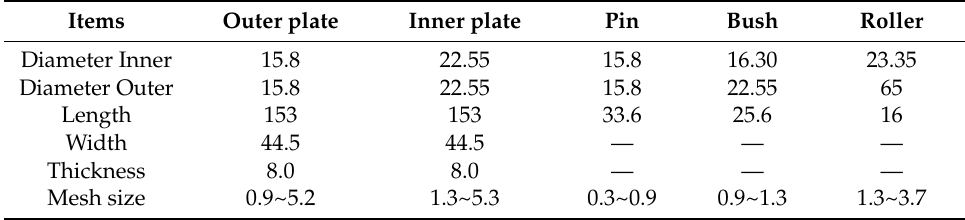
Table 2. Roller chain dimensions and mesh size [mm].